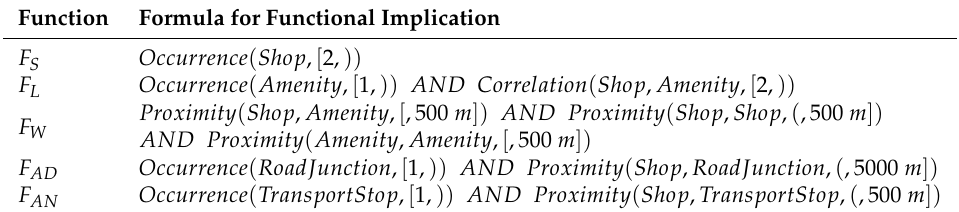
Table 4. Theoretical pattern for places functioning as shopping areas.